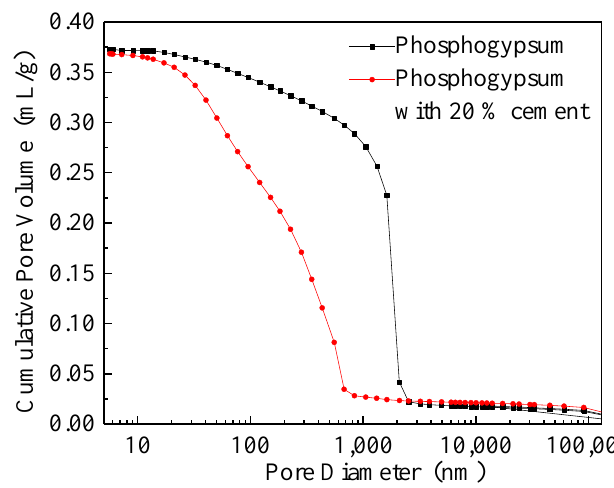
Figure 8. Relationship between pore size and mercury intake.